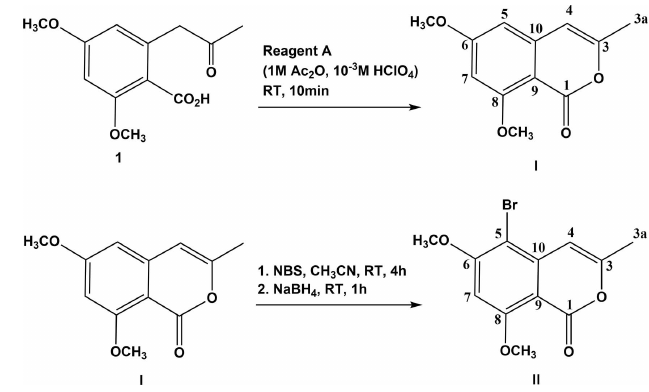
Figure 7 The full two-dimensional fingerprint plot for compound I , and fingerprint plots delineated into H (cid:2)(cid:2)(cid:2) H (40.3%), O (cid:2)(cid:2)(cid:2) H/H (cid:2)(cid:2)(cid:2) O (28.2%), C (cid:2)(cid:2)(cid:2) H/ H (cid:2)(cid:2)(cid:2) C (24.6%), C (cid:2)(cid:2)(cid:2) O (3.0%), and O (cid:2)(cid:2)(cid:2) O (2.9%) contacts.